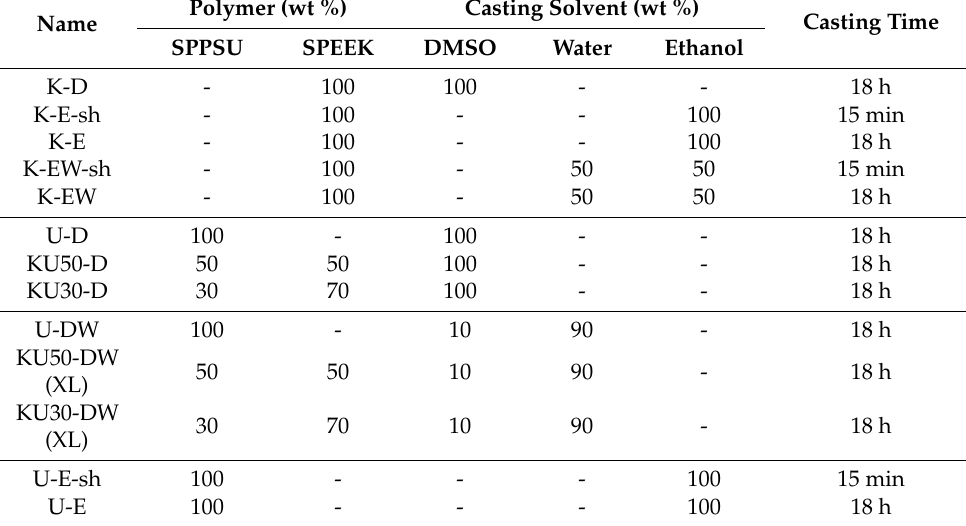
Table 1. Casting conditions of membranes. K stands for SPEEK, U for SPPSU, D for DMSO, W for water, and E for ethanol. XL (crosslink) indicates membranes thermally treated 3 h at 180 ◦ C. sh specifies a short (15 min) heat treatment during casting. The casting temperature in all cases is 80 ◦